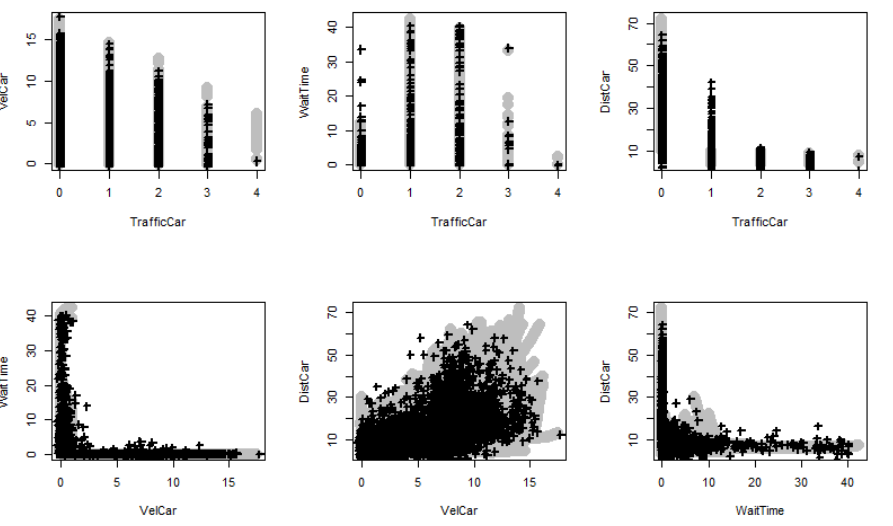
Figure 3. Measured data (grey) and associated simulated data (+) generated with the underlying